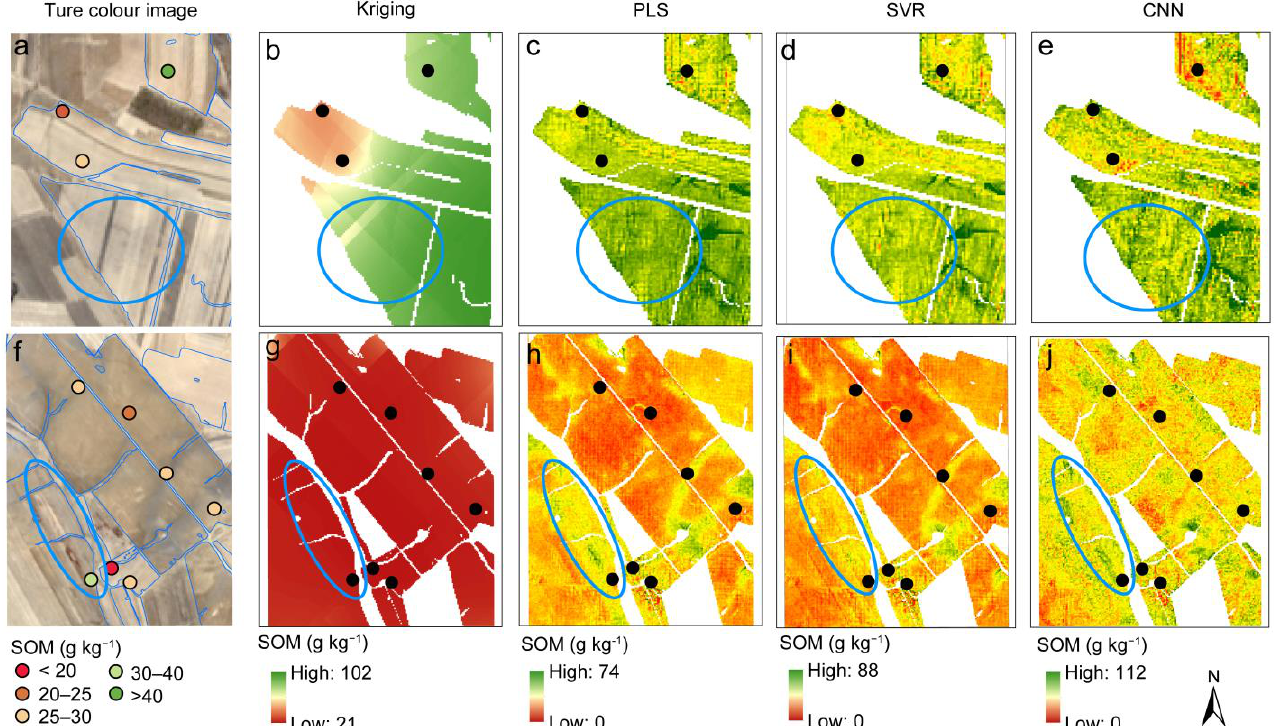
Figure 8. Subareas of the spatial distribution of SOM content in high ( a – e ) and low ( f – j ) SOM estimated by Kriging (( b ) and ( g )), partial least square (PLS, ( c ) and ( h )), support vector regression (SVR, ( d ) and ( i )), and convolutional neural network (CNN, ( e ) and ( j )) methods. Subplots show the zooms of areas in Figure 7. The blue circle areas indicate that machine learning models show abundant and realistic local spatial variability than the Kriging method.